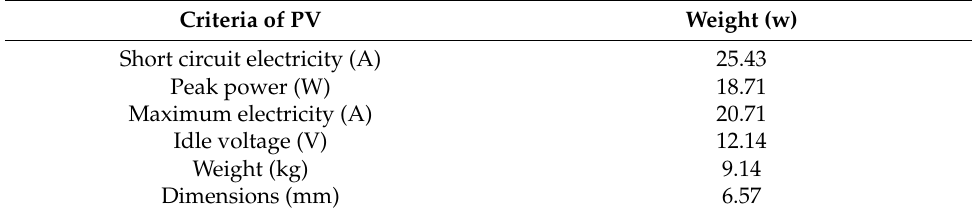
Table 2. Weights of PV criteria.